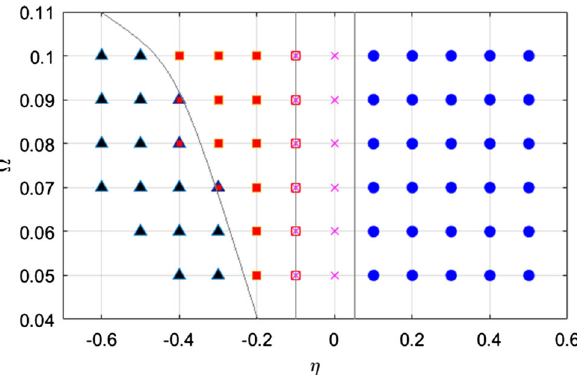
Fig. 8 Ω − η phase diagram of the vortex states, where (cid:12) symbolize triangular lattice, (cid:4) symbolize square lattice, × stripe vortex and ◦ vortex sheet